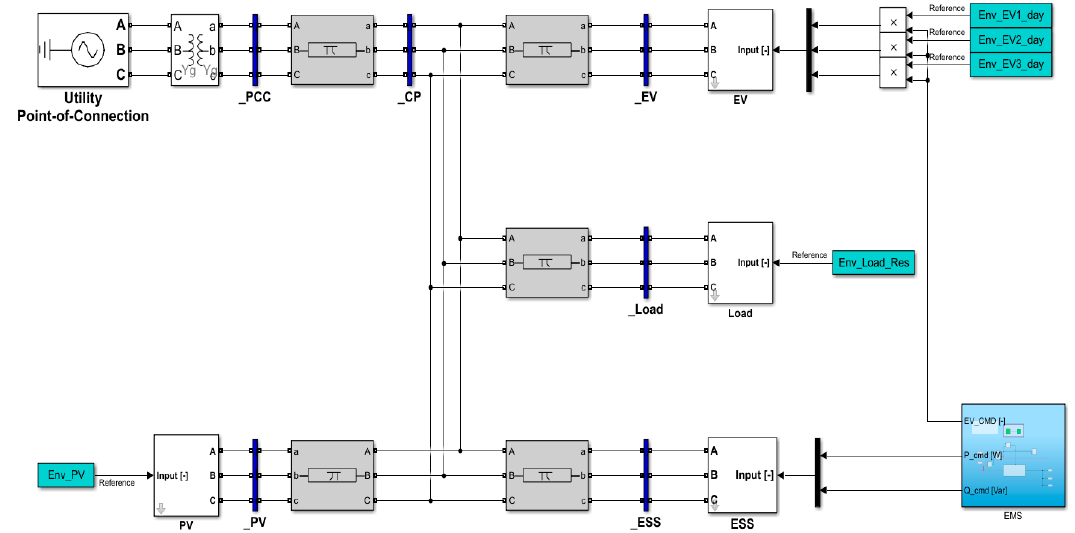
Figure 16. PV-ESS based EV charging infrastructure model (MATLAB/SIMULINK).